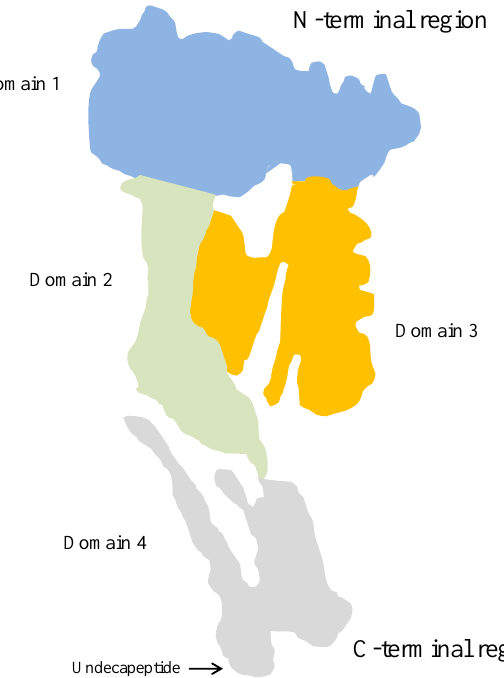
Figure 4. Simplified model of the pyolysin molecule, based on the perfringolysin